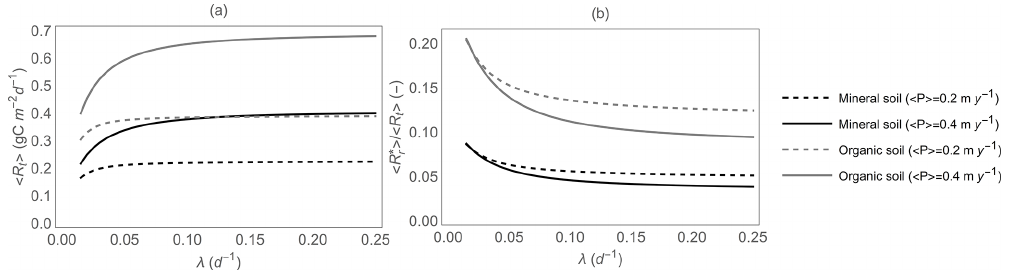
Figure 7. (a) Total heterotrophic respiration (cid:104) R t (cid:105) and (b) fraction of the total heterotrophic respiration rate due to rewetting pulses, (cid:104) R ∗ r (cid:105) / (cid:104) R t (cid:105) , as a function of mean precipitation event frequency λ , for given total precipitation (i.e., α = (cid:104) P (cid:105) /λ ), and for both mineral and organic soils. The respiration model parameters are reported in Table 2, and other parameter values are as in Fig.